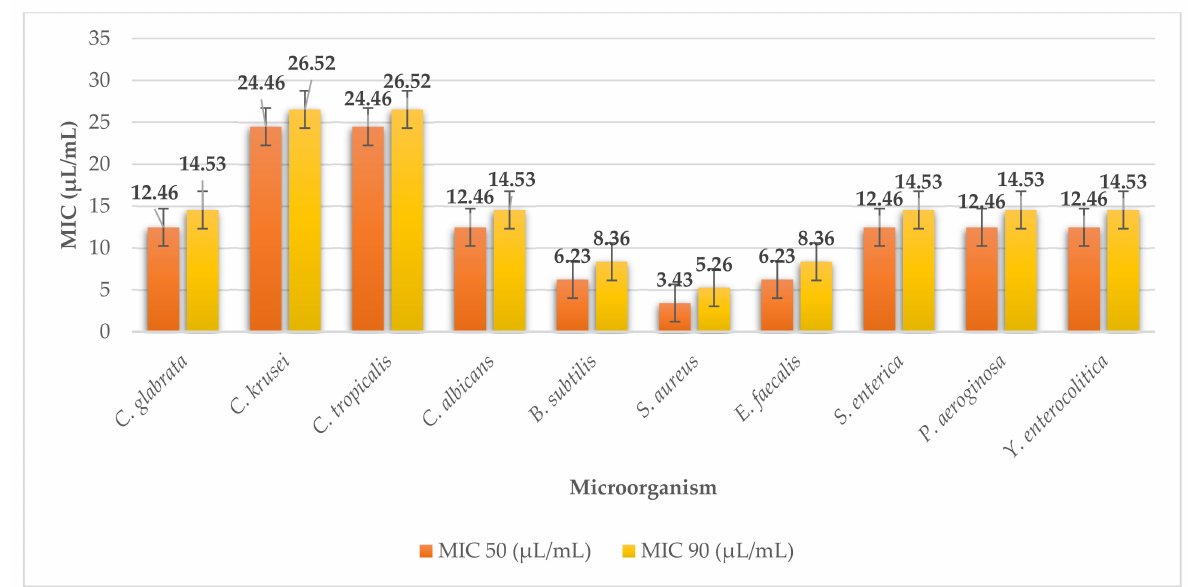
Figure 2. MIC 50 and MIC 90 of kombu.